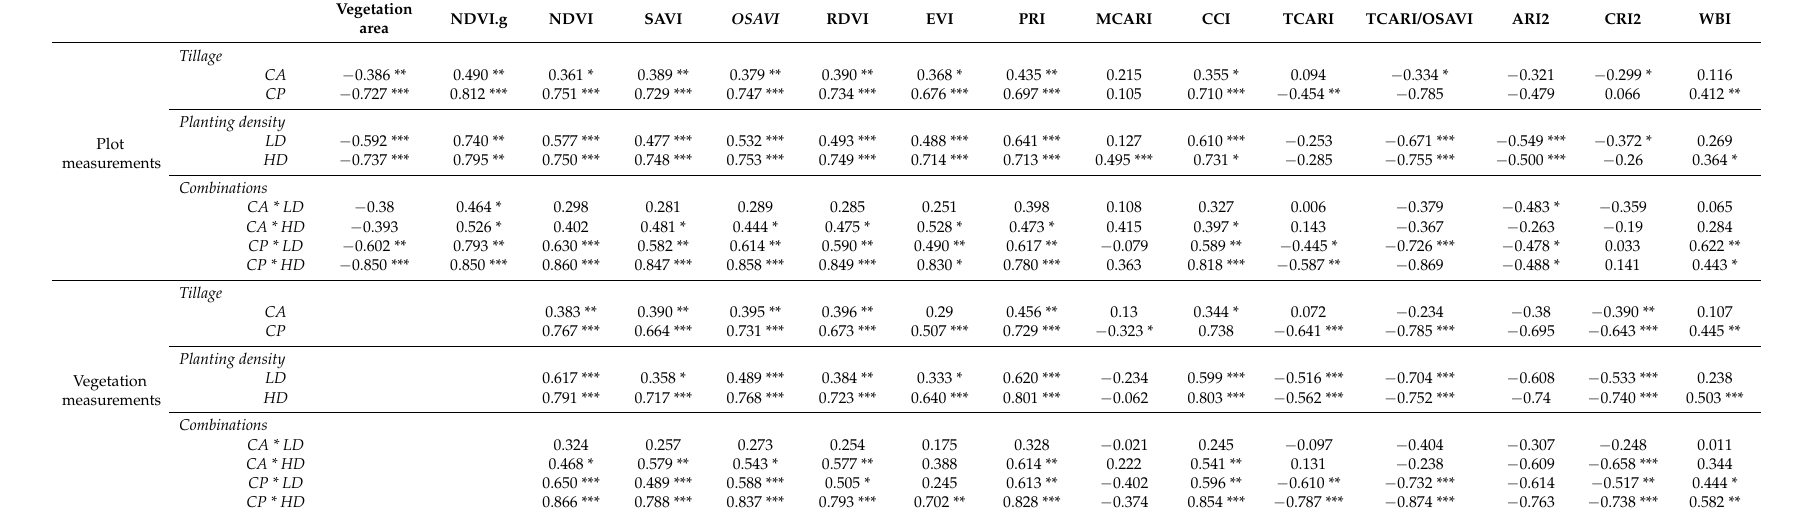
Table 7. Regression coefficients of the relationships between the multispectral-indices, measured at ground and aerial levels, with grain yield. These indices are defined at section Material and Methods. Level of significance ( p -value): *, p < 0.05; **, p < 0.01; ***, p < 0.001. Treatments: CA, conservation agriculture; CP, conventional agriculture; LD, low density; HD, high